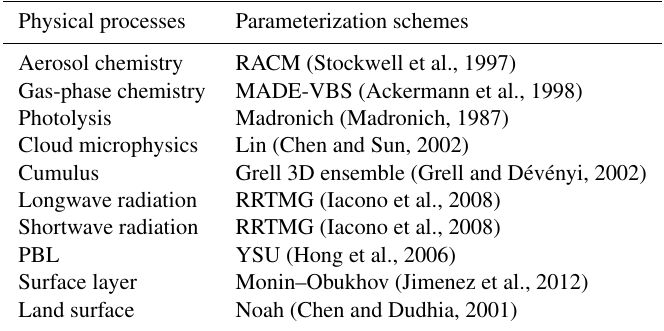
Table 1. Summary of WRF-Chem physics